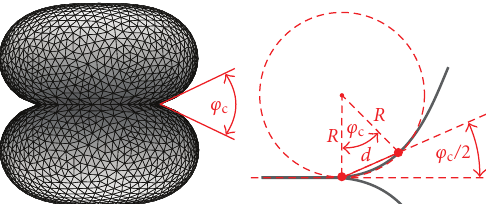
Figure 1: Left: a stable state of the two adhering vesicles obtained by minimization of the energy (3) for the relative volume of each vesicle v = 0 . 9 and for the dimensionless reduced adhesion constant (cid:3) γ = 10. The e ff ective contact angle ϕ c is defined in the right panel. Right: definition of the e ff ective contact angle. The membrane (shown in gray), has at the contact point the contact curvature 1 /R . The secant that defines the e ff ective contact angle ϕ c cuts the membrane at the point of contact and at the distance d that should be small, that is, d (cid:5) R .